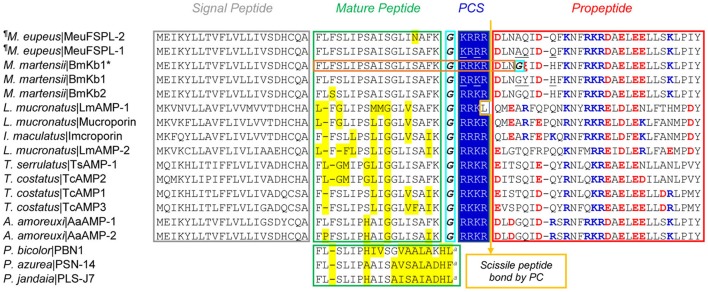
MeuFSPLs and homologs. For each peptide, scorpion species and peptide names are shown. Glycines for C-terminal amidation are italicized and boxed in cyan. PCS, proprotein convertase signal. The arrow represents scissile peptide bond by PC. In the mature region, residues non-identical to MeuFSPL-1 are shadowed in yellow, and in the proregion, charged residues are colored (basic, blue; acidic, red). “a,” amidation. Non-identical residues between MeuFSPL-1 and BmKb1 are underlined once. Except three from frogs (Phyllobates azzurea, P. bicolor, and P. jandaia), all other sequences are derived from scorpions (Androctonus amoreuxi, Isometrus maculatus, Lychas mucronatus, Mesobuthus eupeus, Mesobuthus martensii, Tityus costatus, and Tityus serrulatus). These sequences can be retrieved from GenBank. “¶” represents new sequences reported in this work. The proposed mature peptide encoded by BmKb1* (i.e., marmelittin) is boxed in orange and the premature stop codon is shown by “ξ” in red.